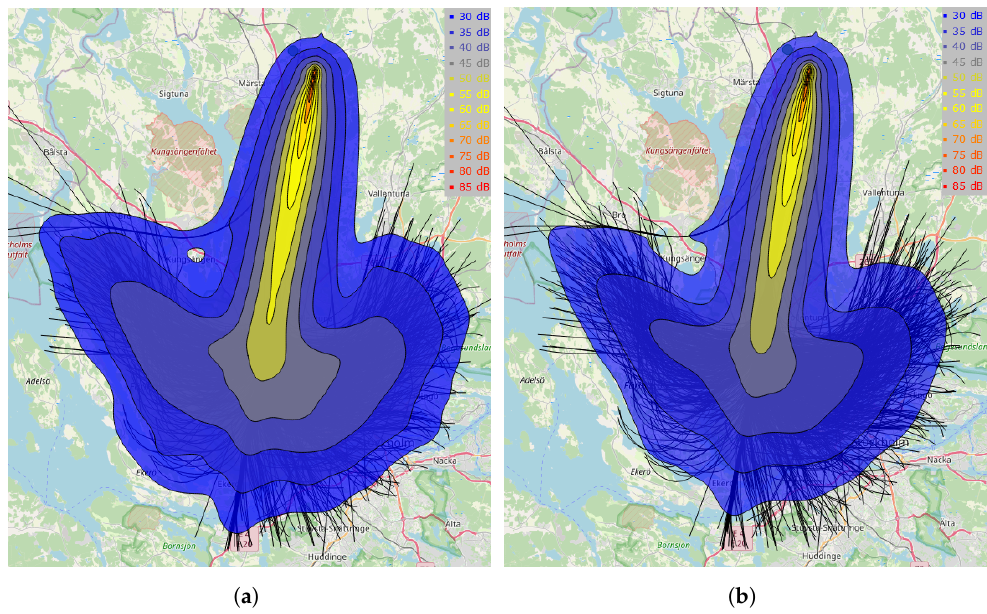
Figure 4. Noise contours ( L den ) ranging from 30 to 85 dB for actual arrival trajectories ( a ) and CDO trajectories ( b ) for Stockholm-Arlanda airport TT dataset in October 2019.